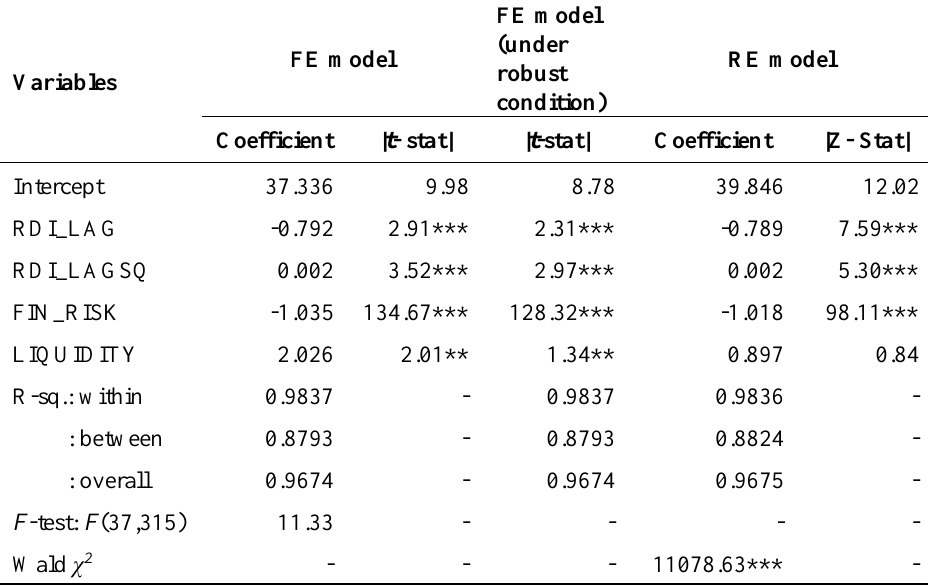
Table 3: Factors Affecting ROA